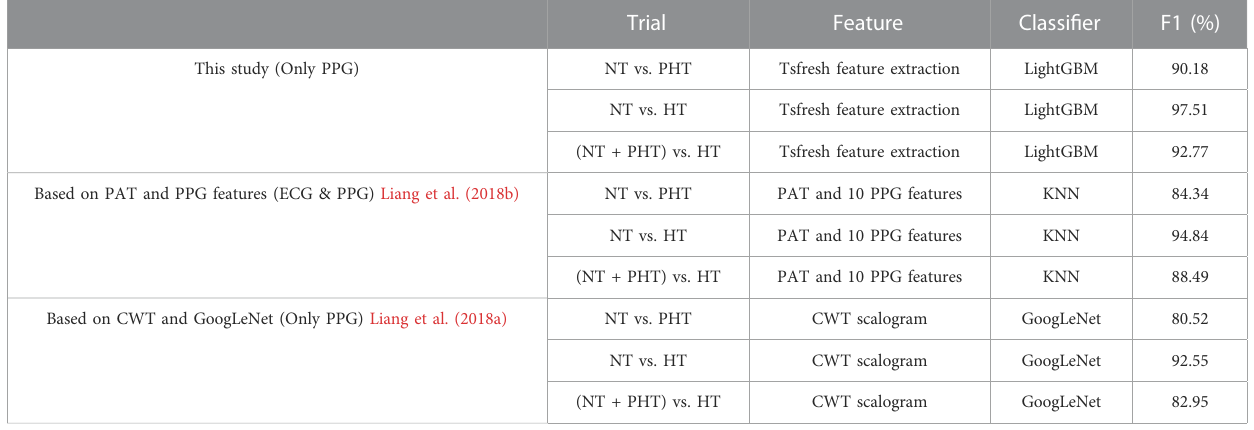
TABLE 4 Classi fi cation performance of the proposed machine learning method and deep learning method and feature-based methods on the same recordings fromtheMIMIC-IIIdatabase.Note,NT,PHT,andHTrefertonormotension,prehypertension,andhypertension,respectively.PATstandsforpulsearrivaltime,CWT stands for continuous wavelet transform, and KNN stands for k-nearest